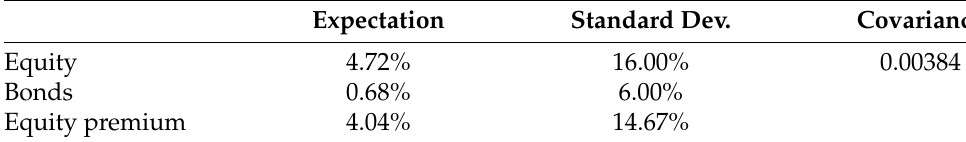
Table 2. The commission’s market view, Norwegian Ministry of Finance (2016). Expectation Standard